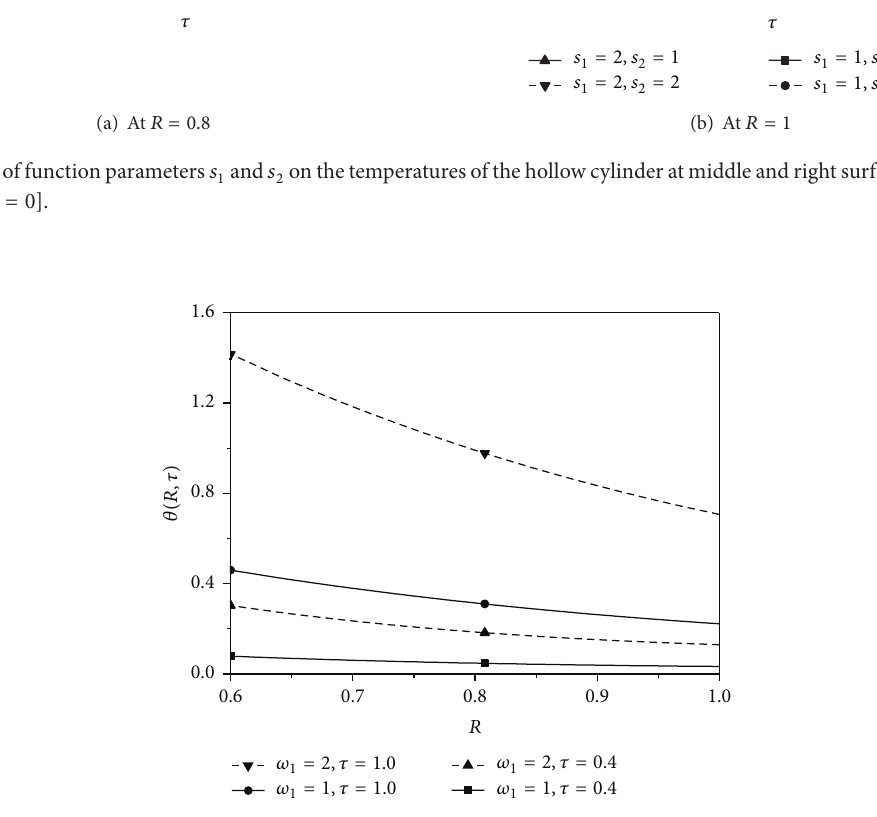
Figure 4: Temperature distribution and variation along the radial of the hollow cylinder with different parameter 𝜔 1 of temperature function 𝜏 , Bi (𝜏) = 2 − 𝑒 −𝜏 , 𝜃 = 𝜓(𝜏) , [ 𝜓(𝜏) = 1 − cos 𝜔 1 0